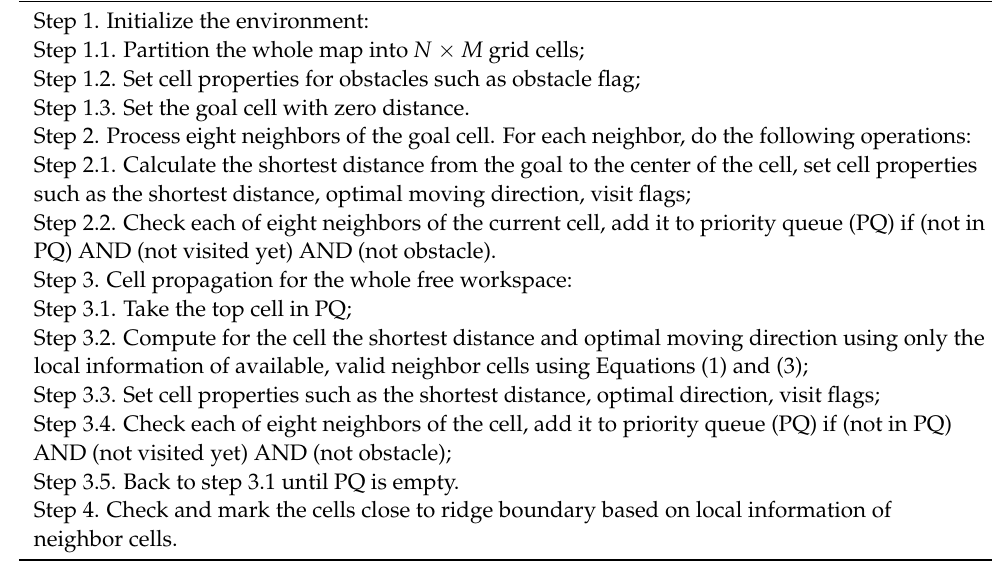
Algorithm 1. DP-Inspired Shortest Distance Path Planning Algorithm